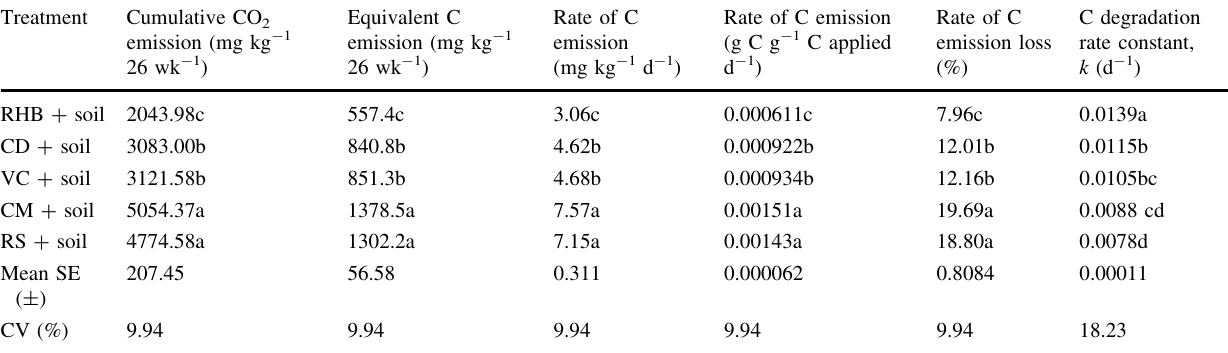
Table 2 Cumulative CO 2 emission and C degradation rate constant for added organic materials